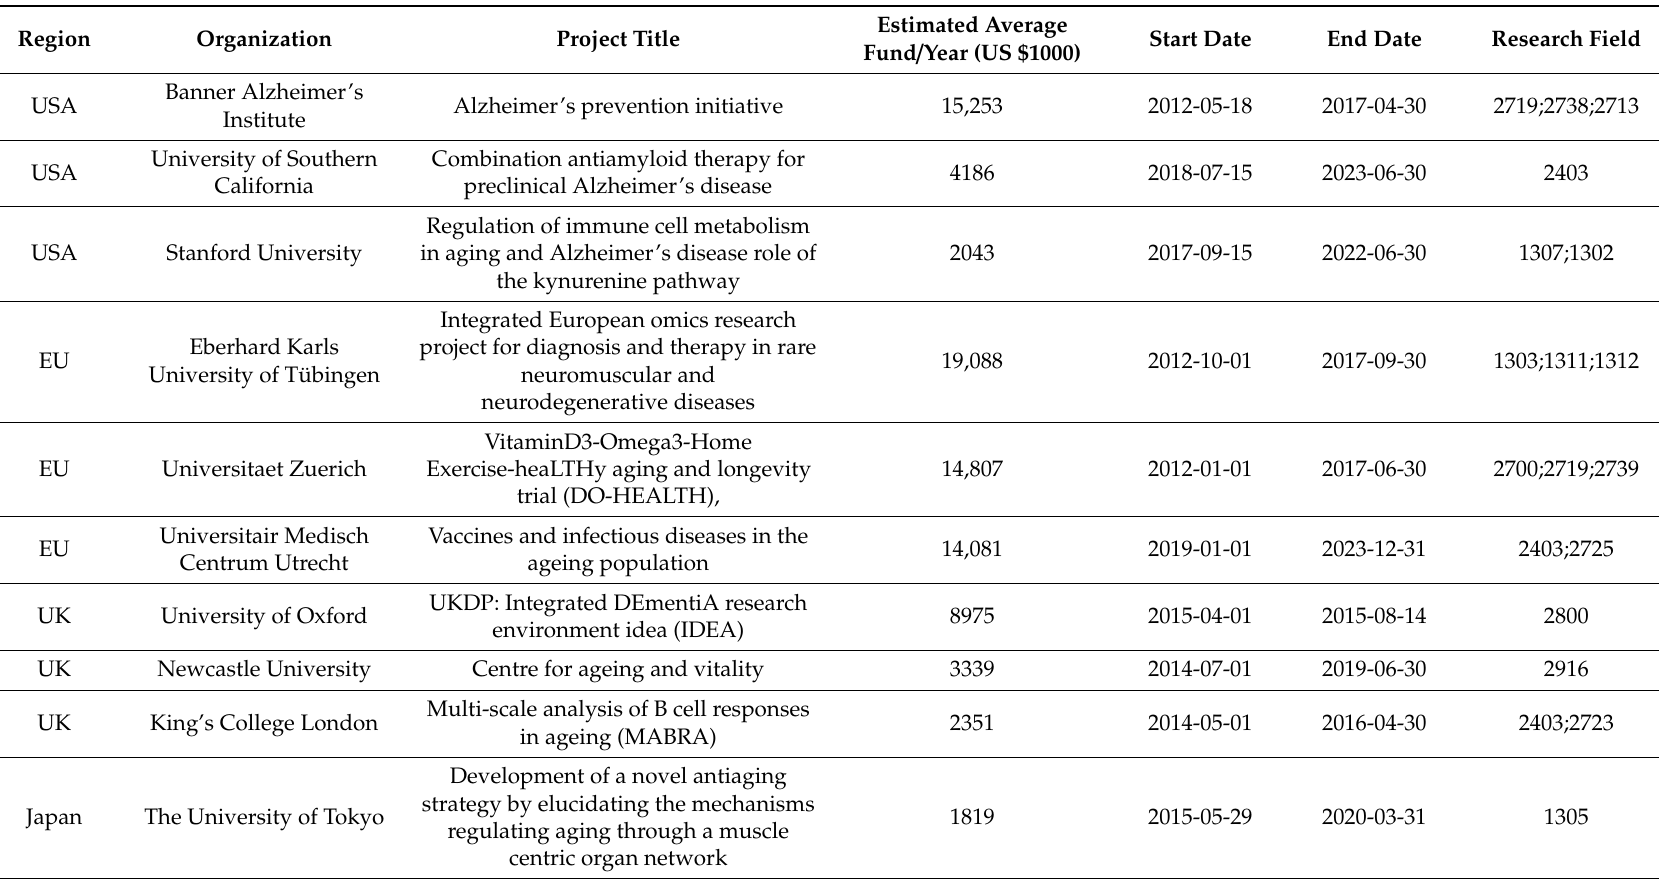
Table 8. The representative national-funded research projects by region, funding, start and end dates, and research field.